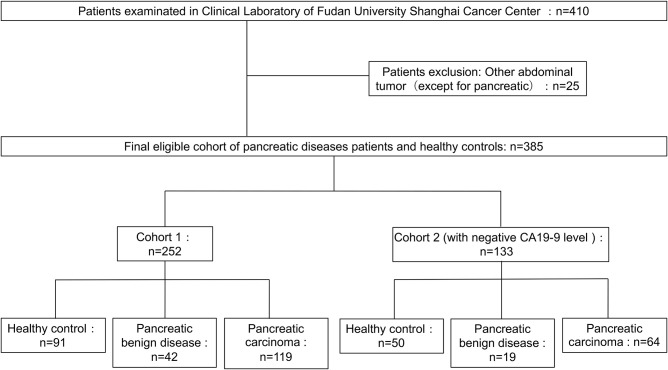
Diagram of study population and cohort selection, with exclusion criteria described on the right-hand side of the diagram.